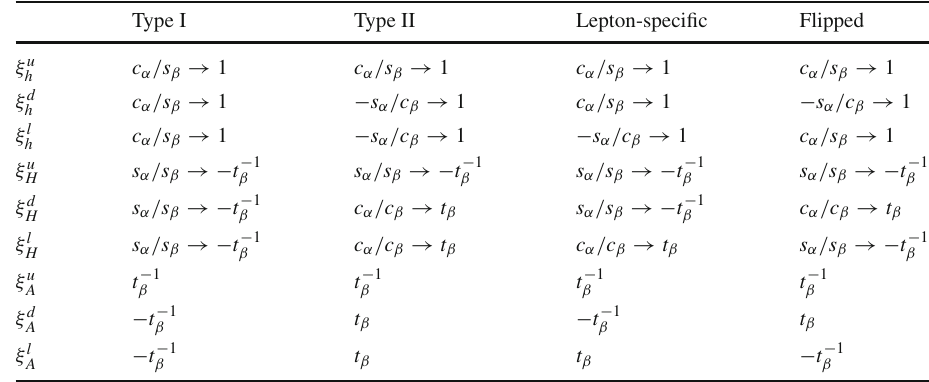
Table 1 Couplings of